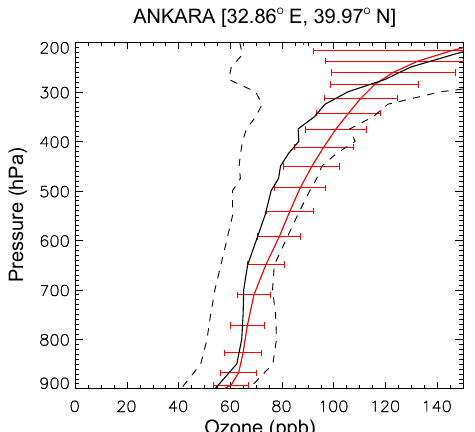
Figure 1. Vertical profiles of JJA ozone (mixing ratios) over Ankara (STN348) for the period 1994–2012. The solid black line represents observations, and the red line refers to EMAC-simulated ozone. The dashed black lines show the observed standard deviations, and the red bars show the model standard deviations.